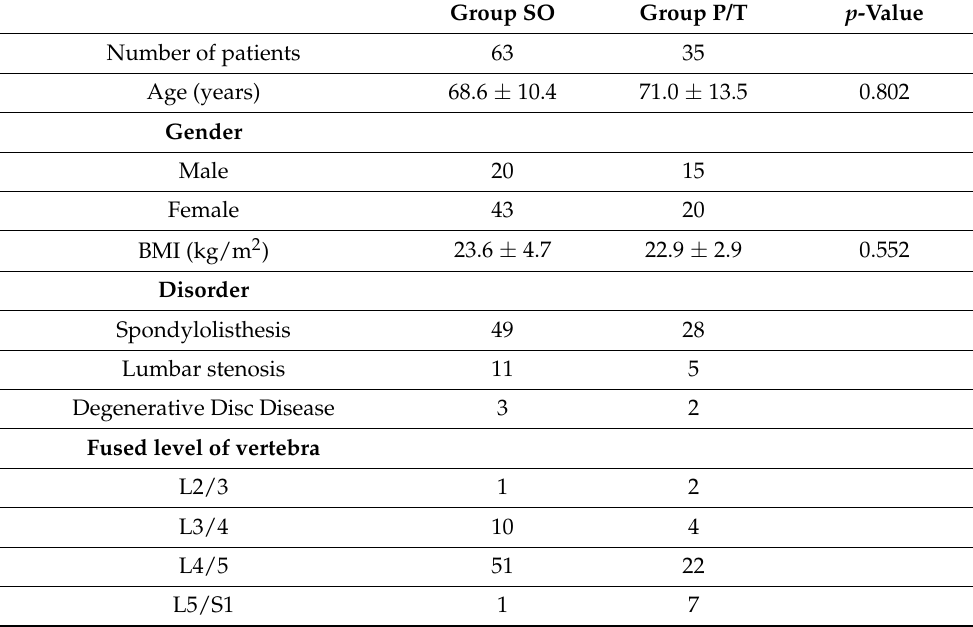
Table 1. Demographic characteristics of patients.